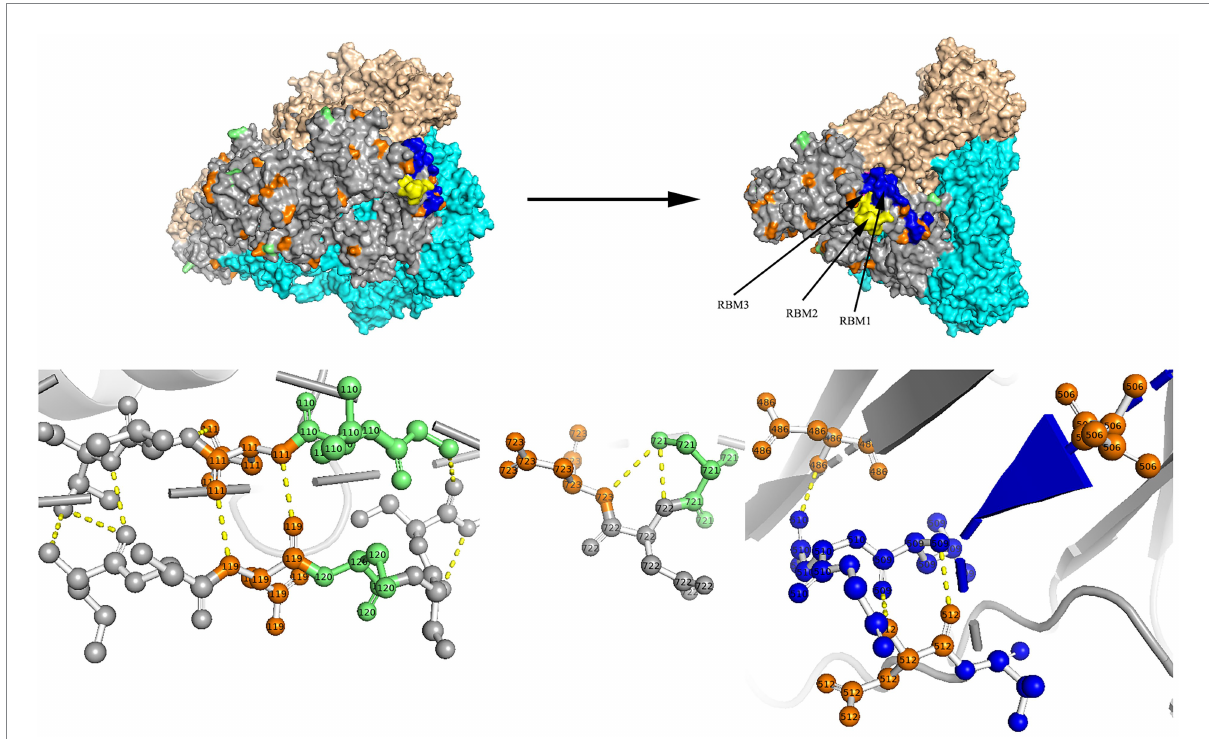
FIGURE 7 N-glycosylation and aa substitution sites of S protein of RS2. Homology modeling was using the template of 7KIP. The trimeric structure model is shown as surface and chains A to C (colored gray, cyan, and wheat, respectively). The N-glycosylation sites and amino acid substitution sites are shown in orange and green, respectively. RBM1, RBM2 and RBM3 in the RBD region are shown in blue, yellow and magenta, respectively. The dashed yellow line indicates polar contact between the